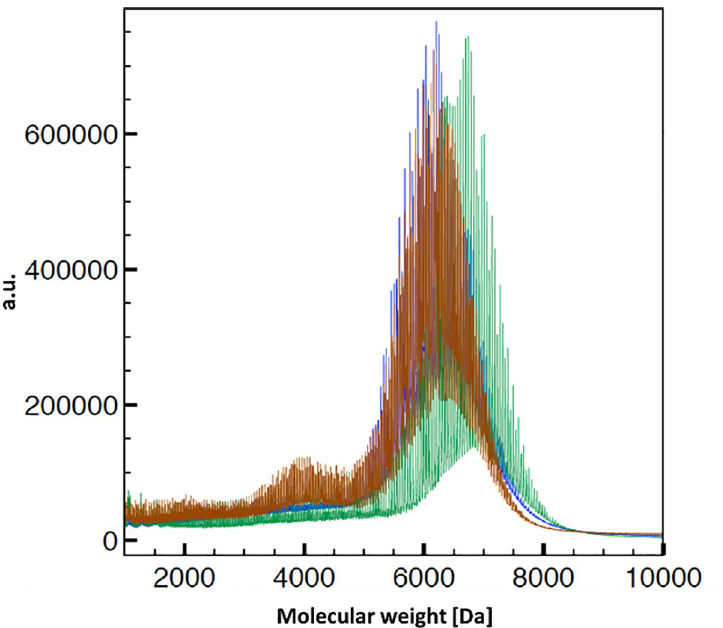
Fig 3. MALDI measurements to determine the mass of PEG 6000 produced by S.A. (green), Merck (blue), C.E. (red).